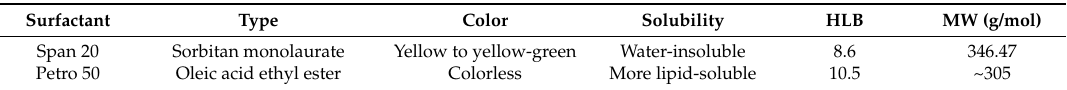
Figure 11. Approximate 2D Structure of ( a ) Span 20 and ( b ) Petro 50 surfactants employed for the preparation of NCS20 and NCP50 materials, respectively. Table 3. Properties of type, color, solubility, hydrophilic-lipophilic balance (HLB), and molecular weight (MW) Span 20, and Petro 50 surfactants.